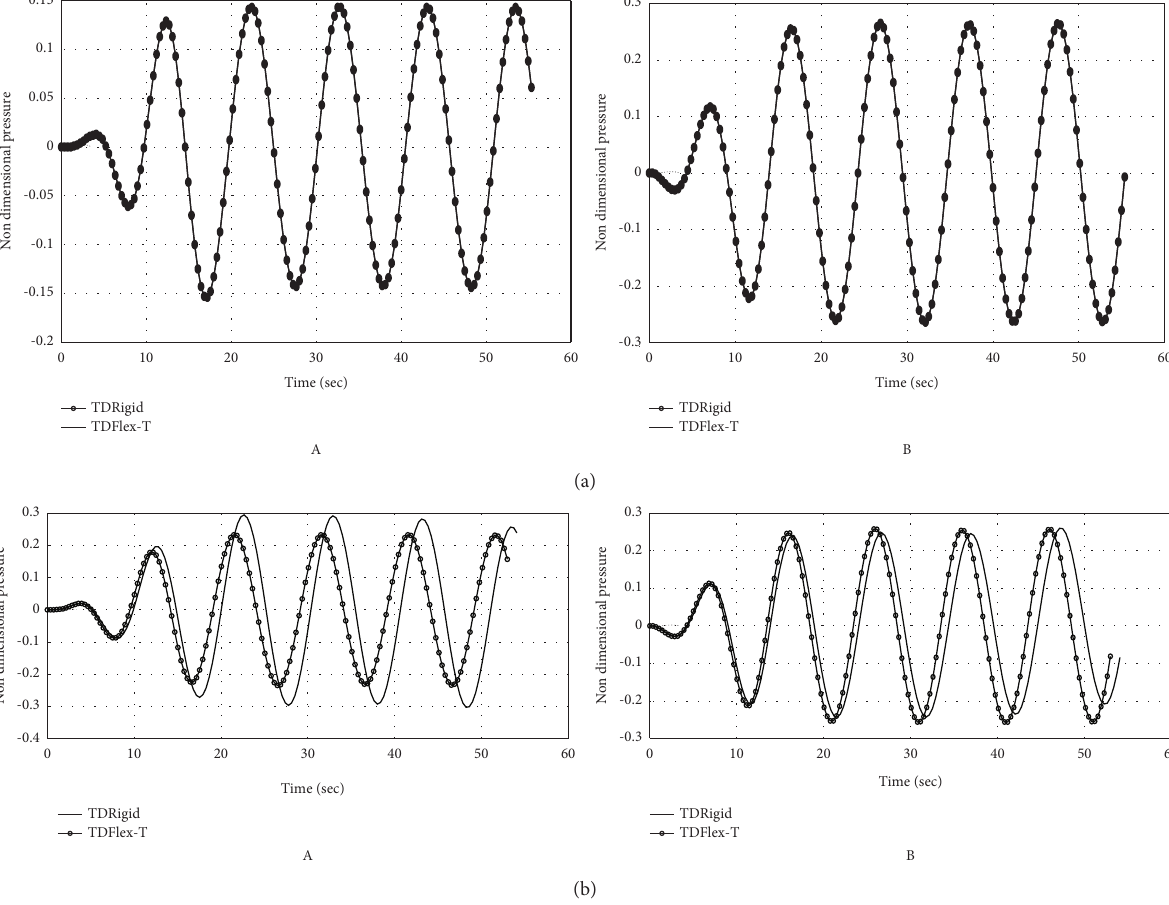
Pressure at free surface (Figure 17; location point n � 0 . 25, λ / L � 1. (A) n